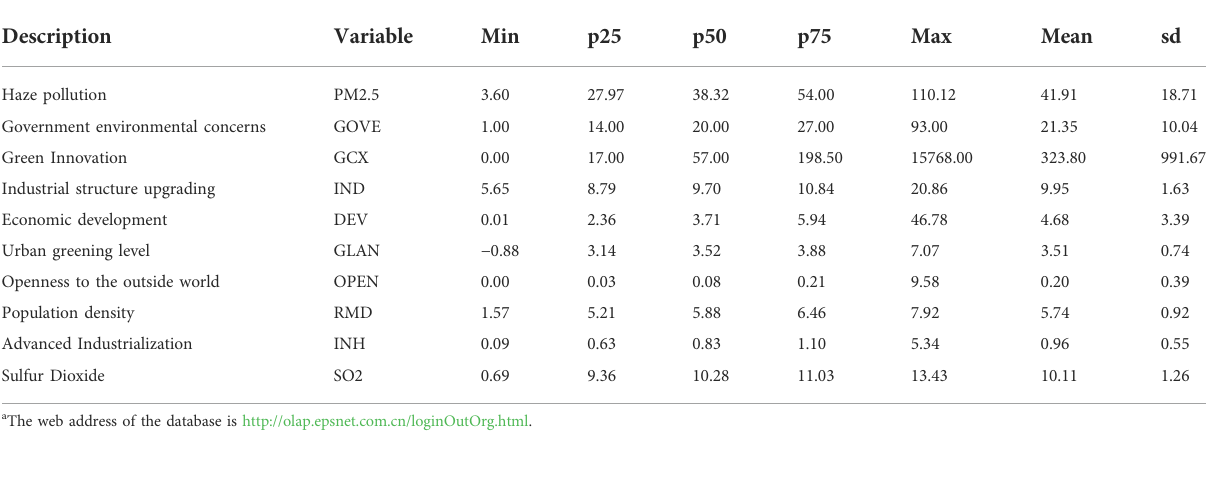
TABLE 1 Descriptive statistics for each variable.